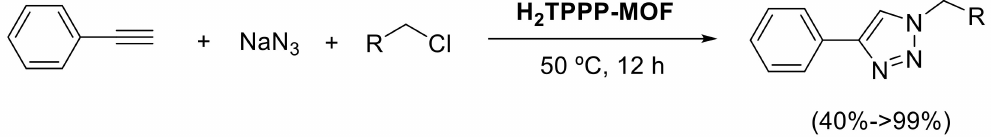
Scheme 56. Schematic representation of the azide-alkyne click reactions catalyzed by the heterogeneous porphyrin-MOF